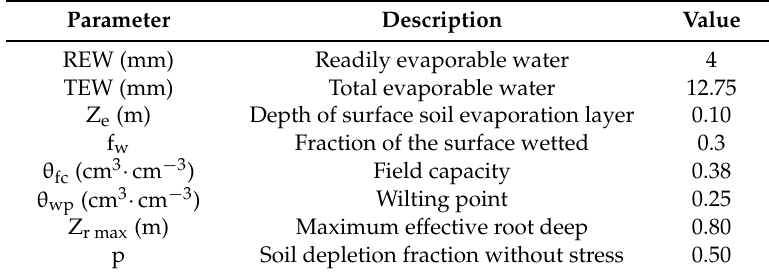
Table 1. Parameters used in the soil water balance based on the FAO-56 methodology for apple